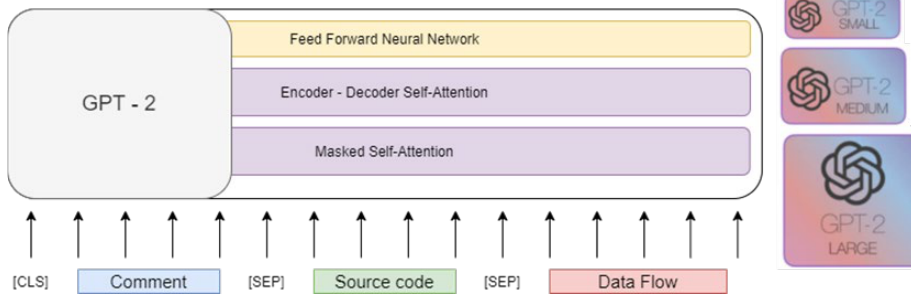
Figure 3. GraphCodeGPT architecture.